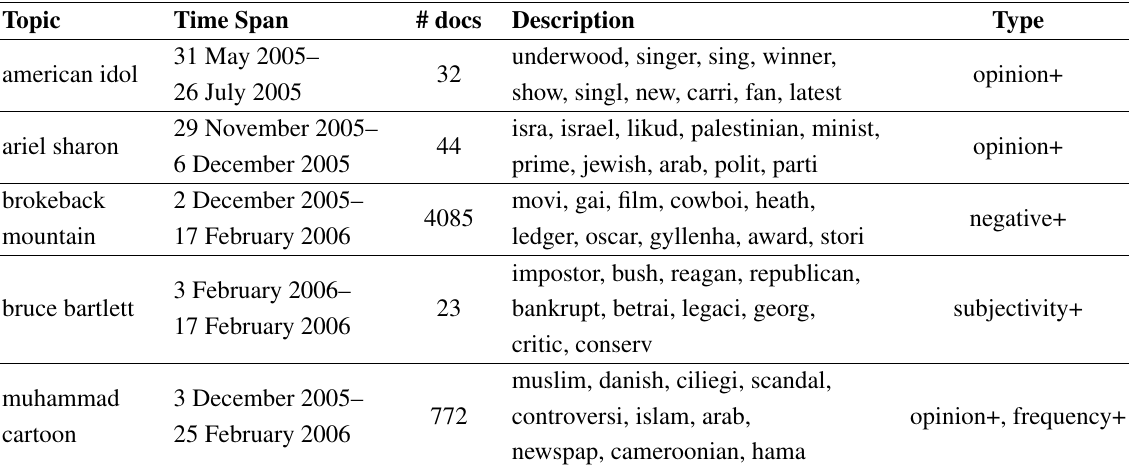
Table 5. Sample events extracted using burst detection on opinion